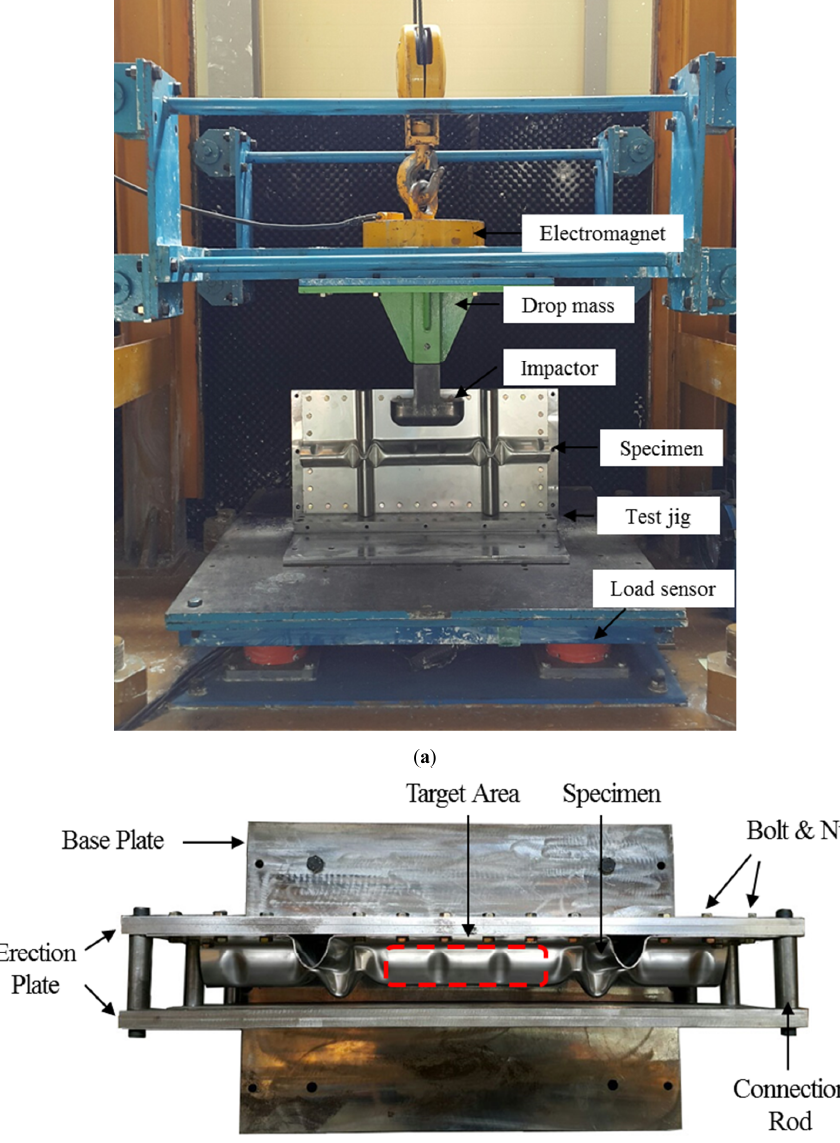
Figure 3. ( a ) Custom-built structural impact test equipment and ( b ) fixing jig with large corrugation